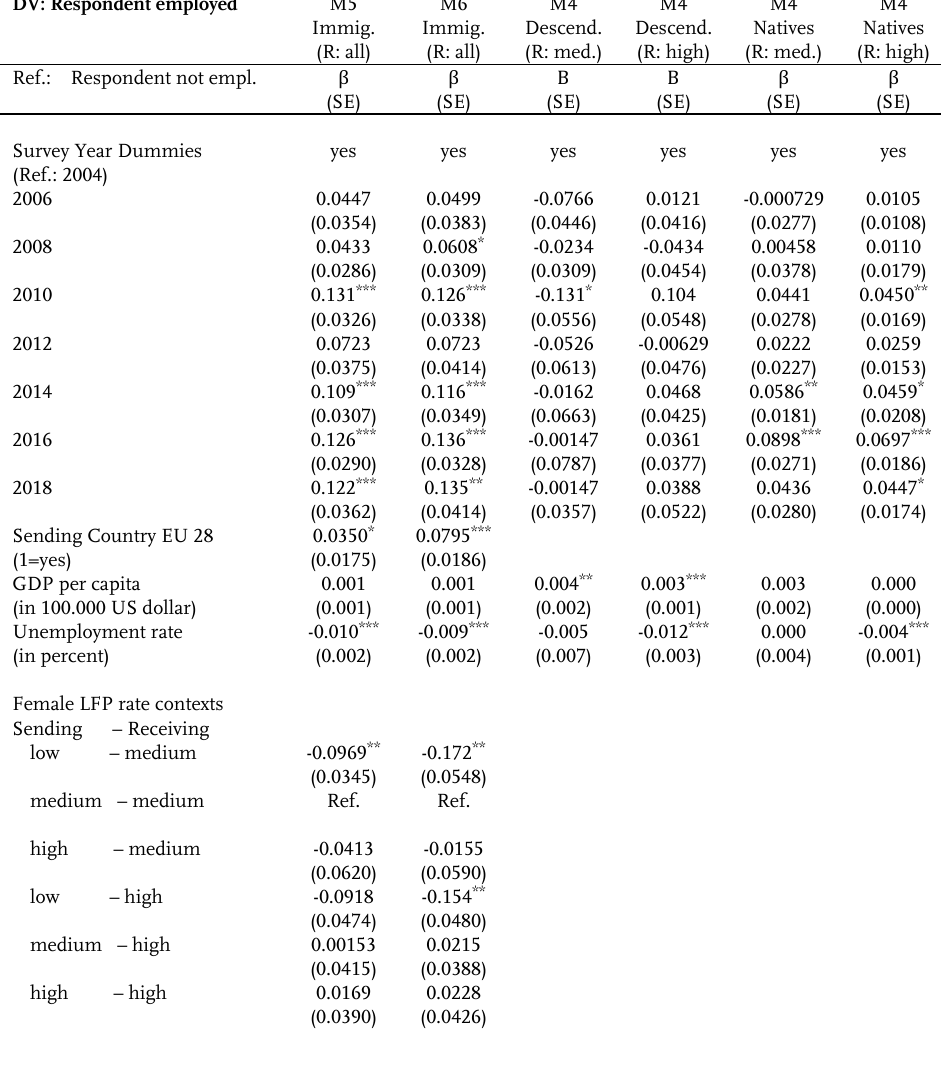
Table A.5 : Full models M5 and M6 for immigrants, M4 for descendants and